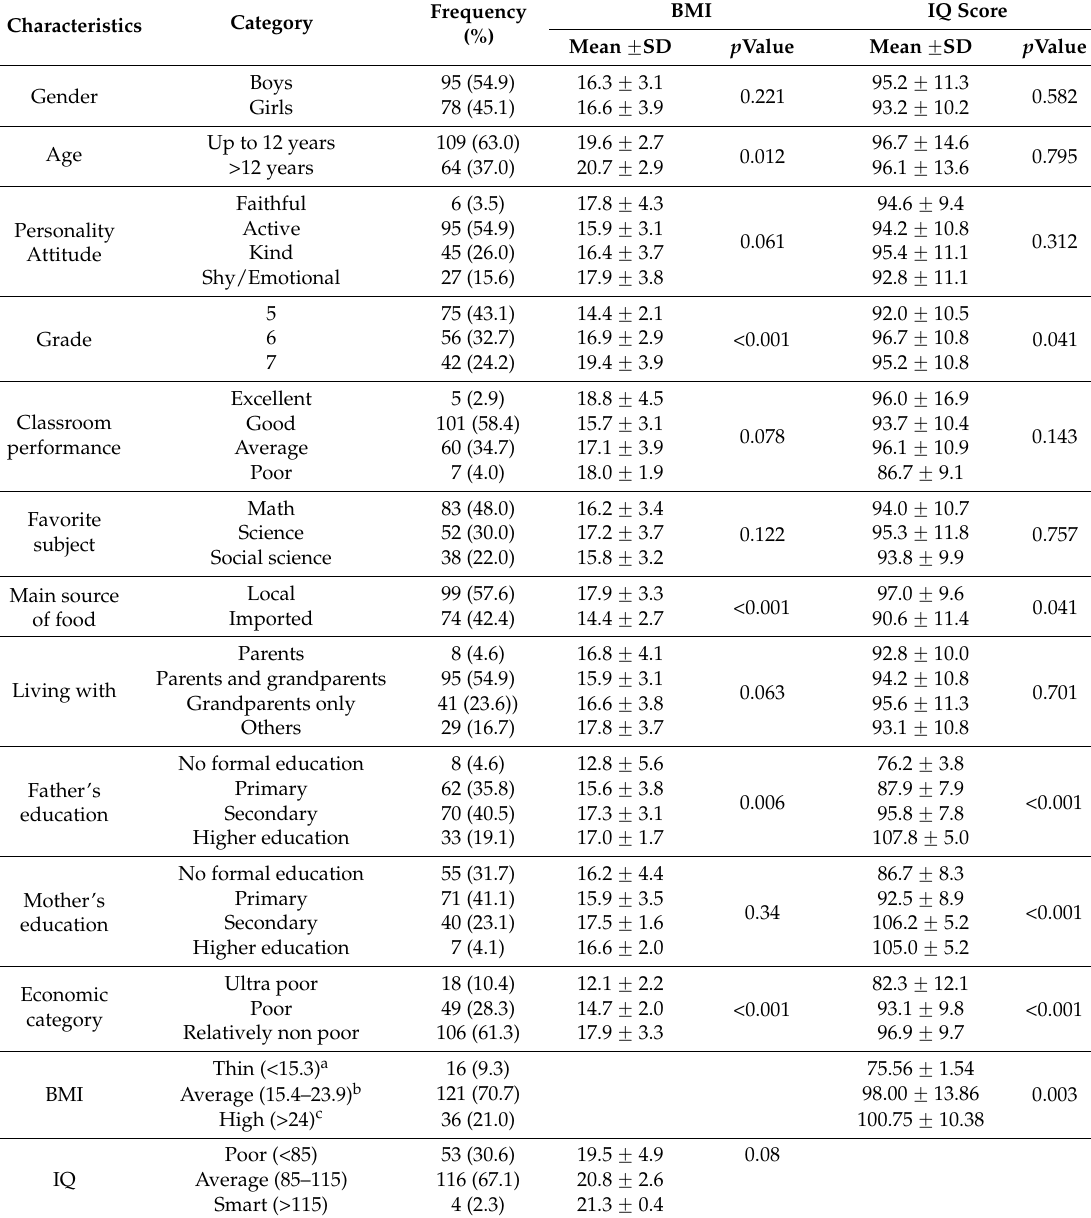
Table 1. Mean and standard deviation of BMI and IQ score with different predictors ( n = 173).